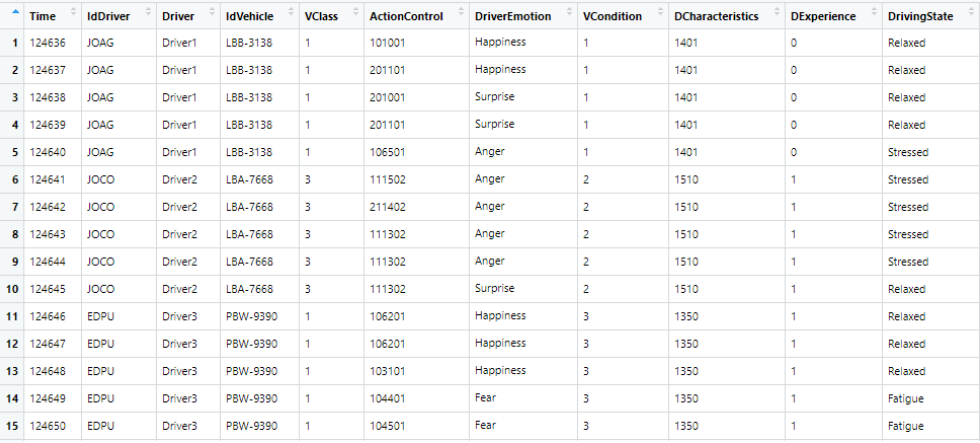
Figure 9. Example of our artificial dataset.